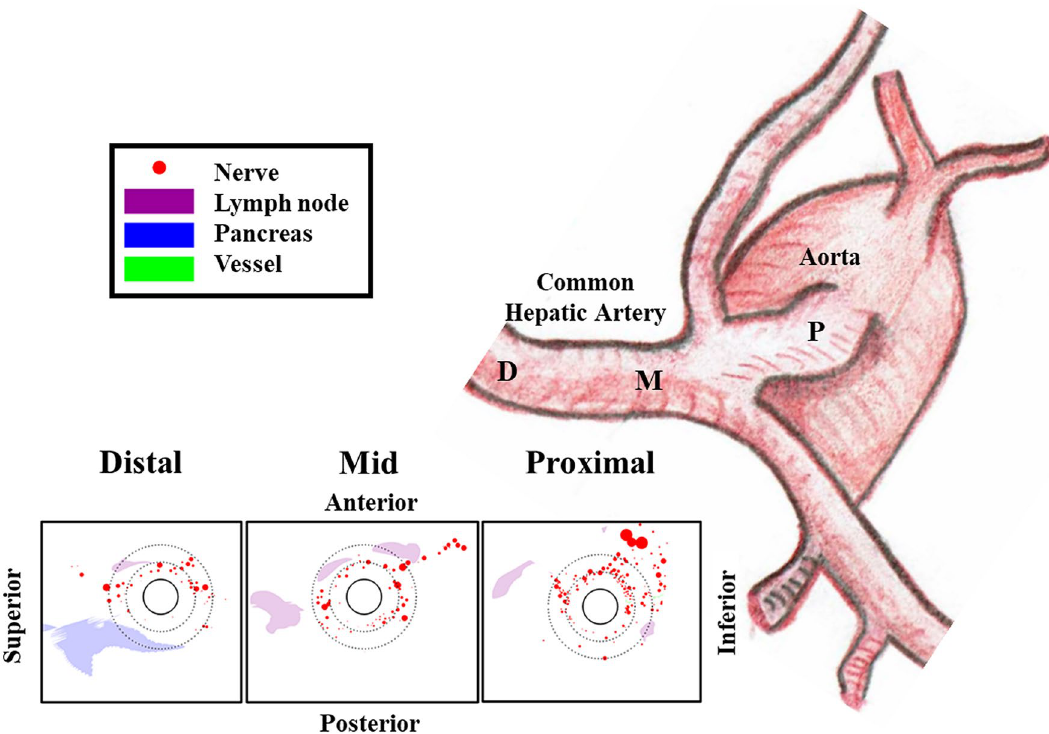
Figure 4. Central illustration: asymmetric periarterial innervation and anatomies. Histological sections reveal a complex periarterial anatomy rich not only in target nerves, but also in adjacent lymph nodes, vessels and pancreas that should be spared from ablation. Nerve abundance decreases with distance from the aorta whereas minimal pancreas distance from the lumen is minimal closest to the aortic